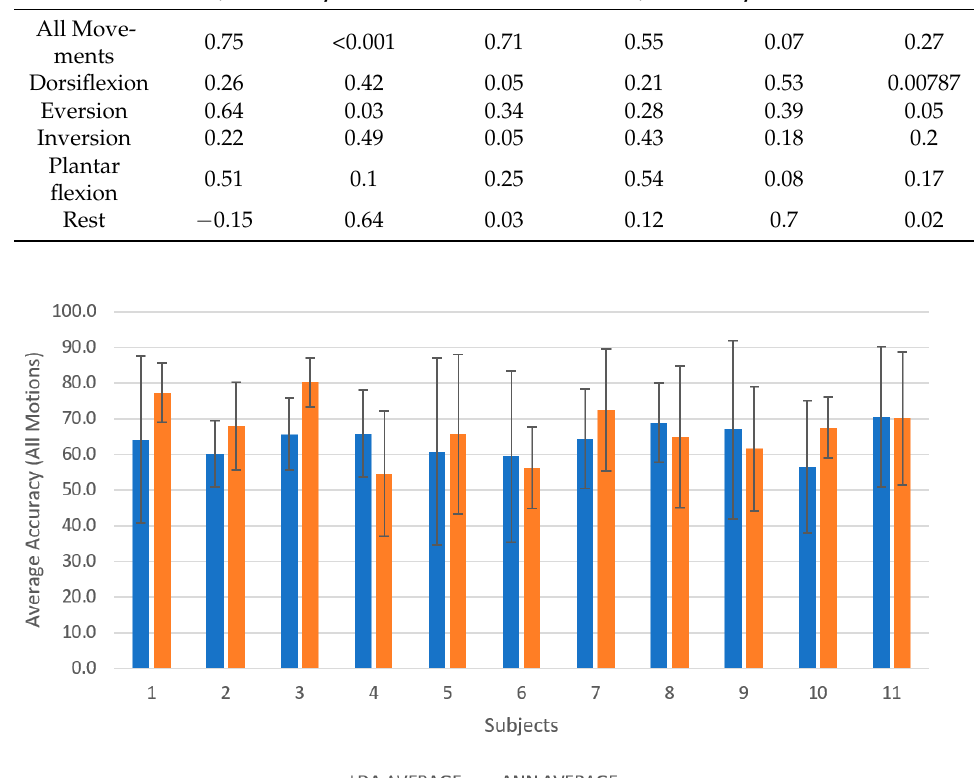
Figure 3. A column graph representing the average classification accuracies for all subjects using linear discriminant analysis (LDA) and artificial neural network (ANN) reported in the form of mean ± standard deviation.